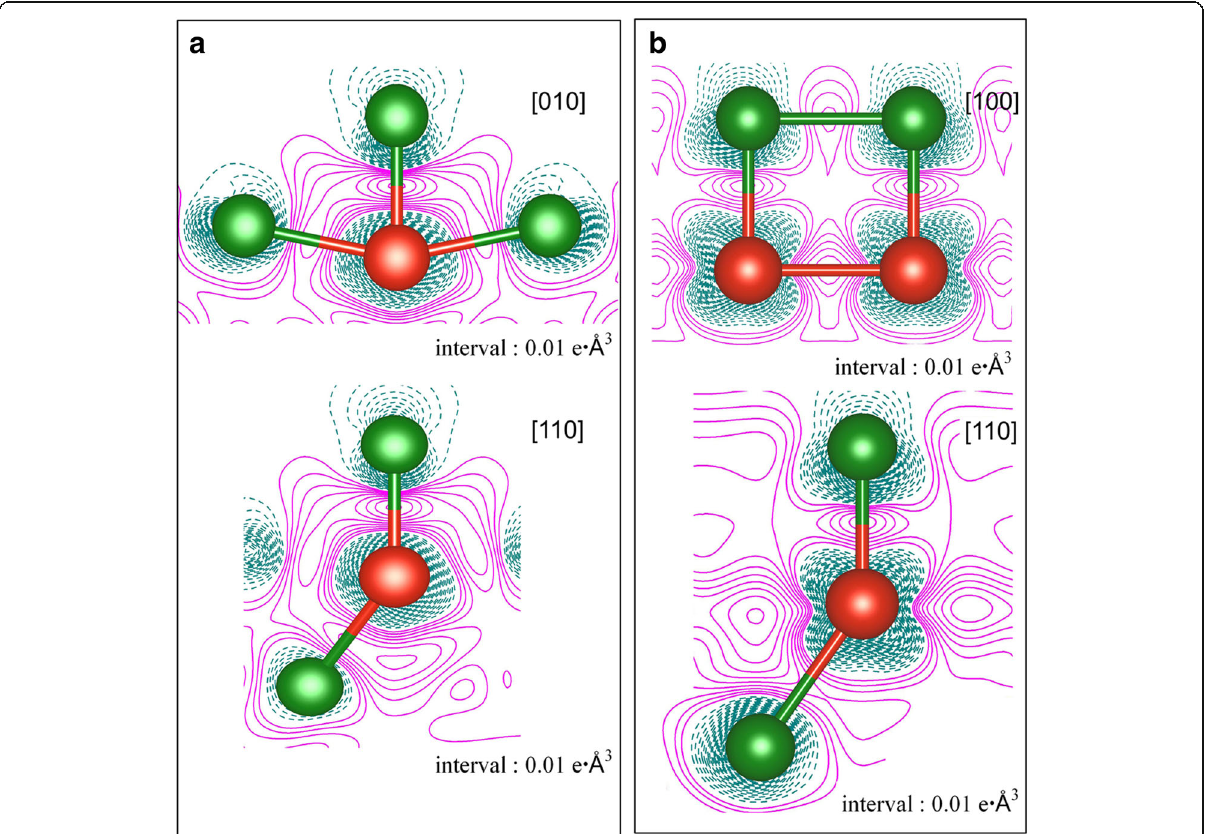
Fig. 5 Deformation charge densities for the adsorption of V atoms on Cu(111) surface at two coverages, i.e., a 1/9 ML and b 1 ML. Electron accumulation and depletion are represented by magenta solid lines and dark cyan dash lines, respectively. The green and red balls represent Cu and V atoms,